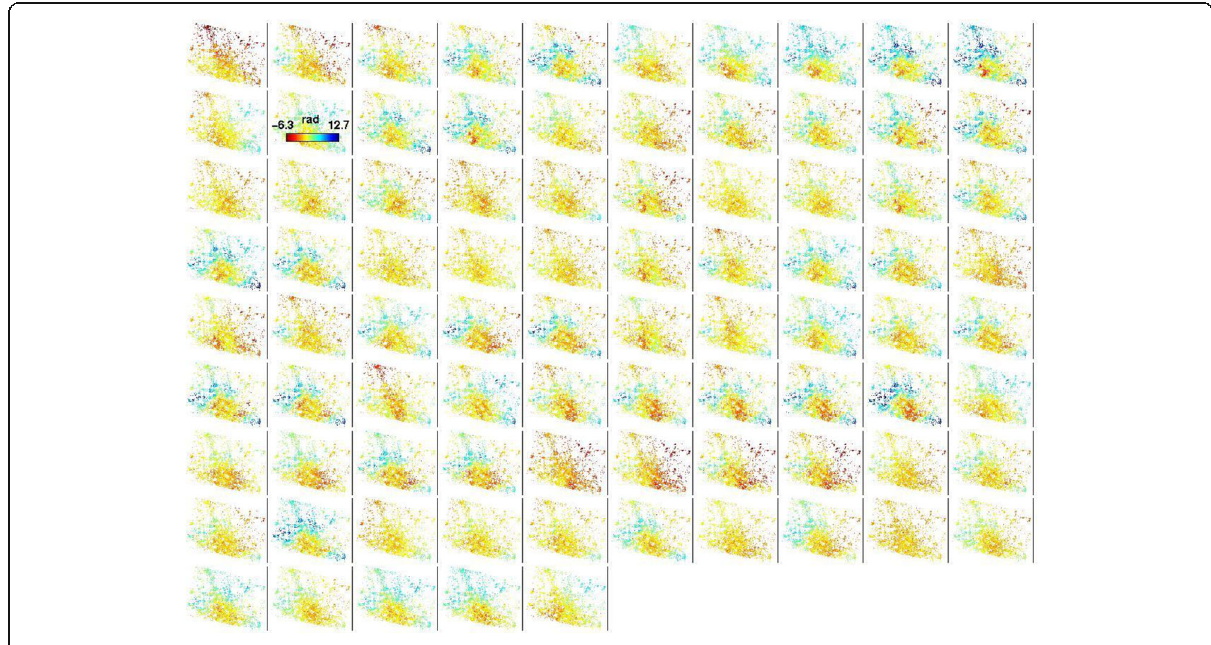
Fig. 4 Figure of short baseline difference interferogram image